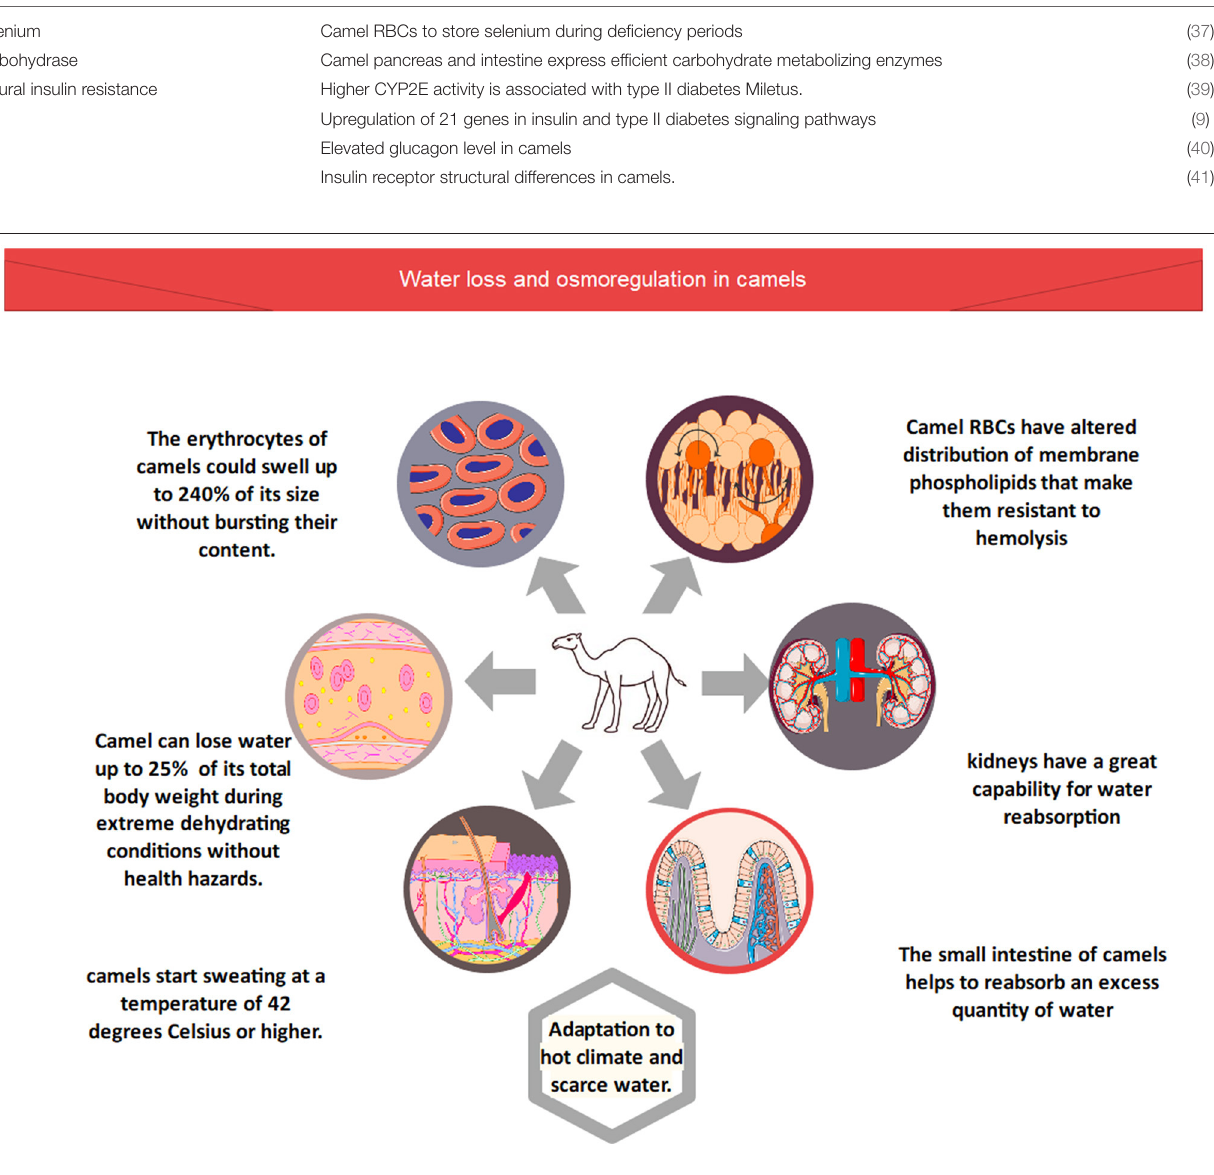
FIGURE 1 | Water loss and osmoregulation in